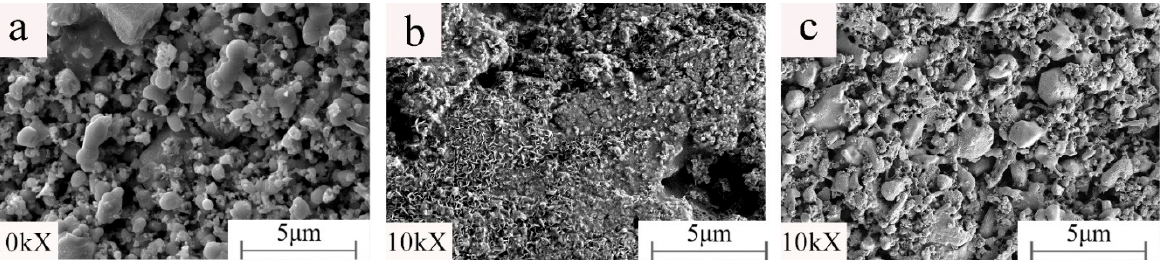
Figure 7. Samples prepared with different microwave susceptors: ( a ) AC; ( b ) SiC; ( c ) AC/SiC = 1.